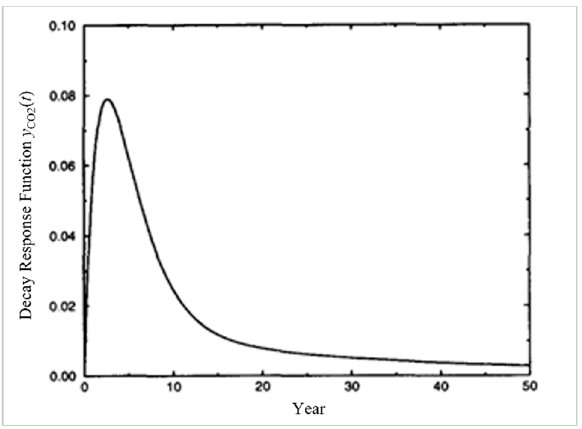
Figure 2. Example of decay response function y CO2 ( t ) [25].